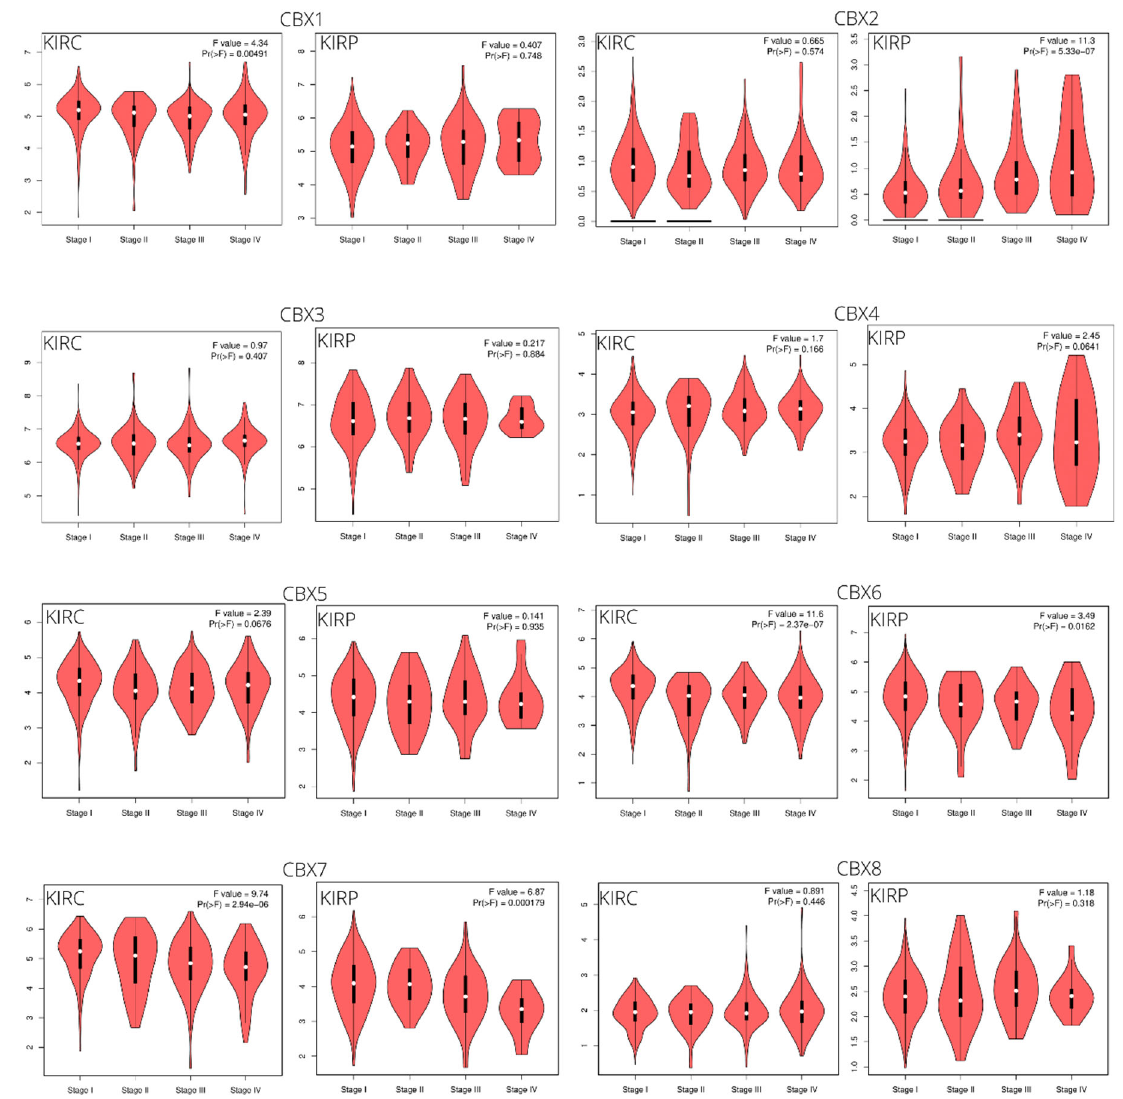
Figure 3. Association between CBX expression levels and clinical stage of ccRCC (KIRC) and pRCC (KIRP) patients. Analyses were performed using GEPIA2 * p < 0.05.